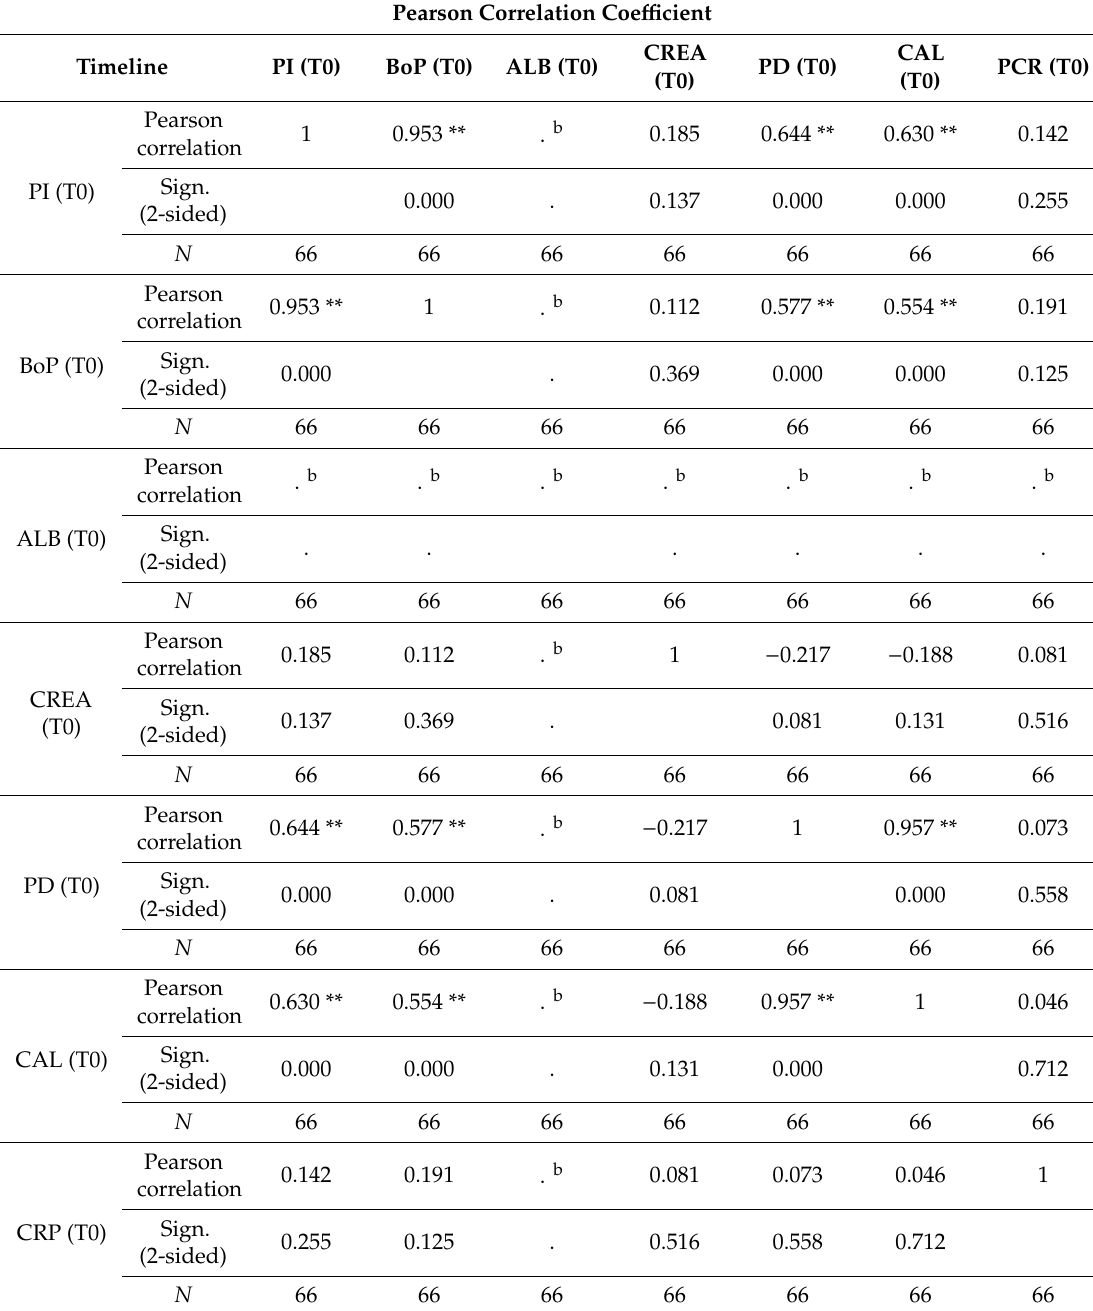
Table 3. Pearson correlation coe ffi cient of variables at